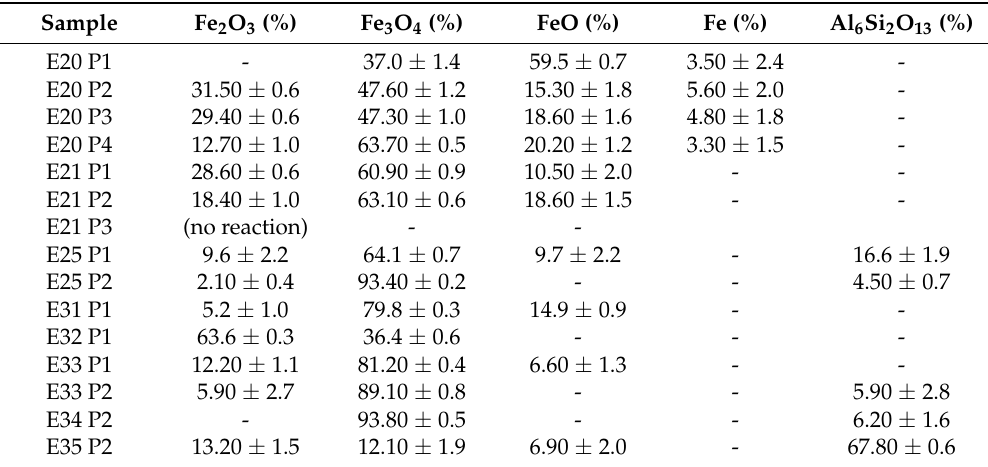
Table 9. Quantities of each phase in the final